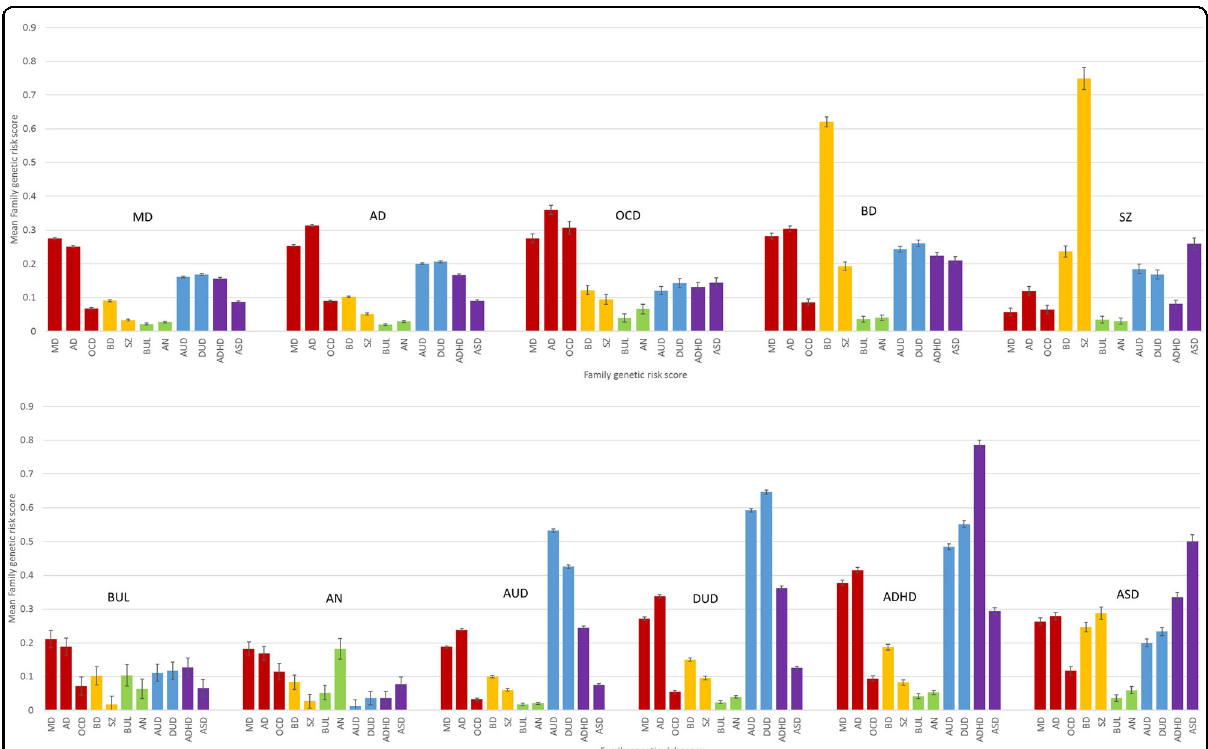
Fig. 1 The mean Genetic Risk Score for 11 disorders in individuals diagnosed with those 11 disorders grouped by Disorder. The y -axis is the mean z -score for the genetic risk scores. The disorders are: major depression (MD), anxiety disorders (AD), obsessive-compulsive disorder (OCD), bipolar disorder (BD), schizophrenia (SZ), bulimia (BUL), anorexia nervosa (AN), alcohol use disorder (AUD), drug use disorder (DUD), ADHD, and autism-spectrum disorder (ASD). For clarity, we provide different color codes for the disorders divided into fi ve categories of internalizing disorders (MD, AD, and OCD), psychotic disorders (BD and SZ), eating disorders (BUL and AN), substance use disorders (AUD and DUD), and neurodevelopmental disorders (ADHD and